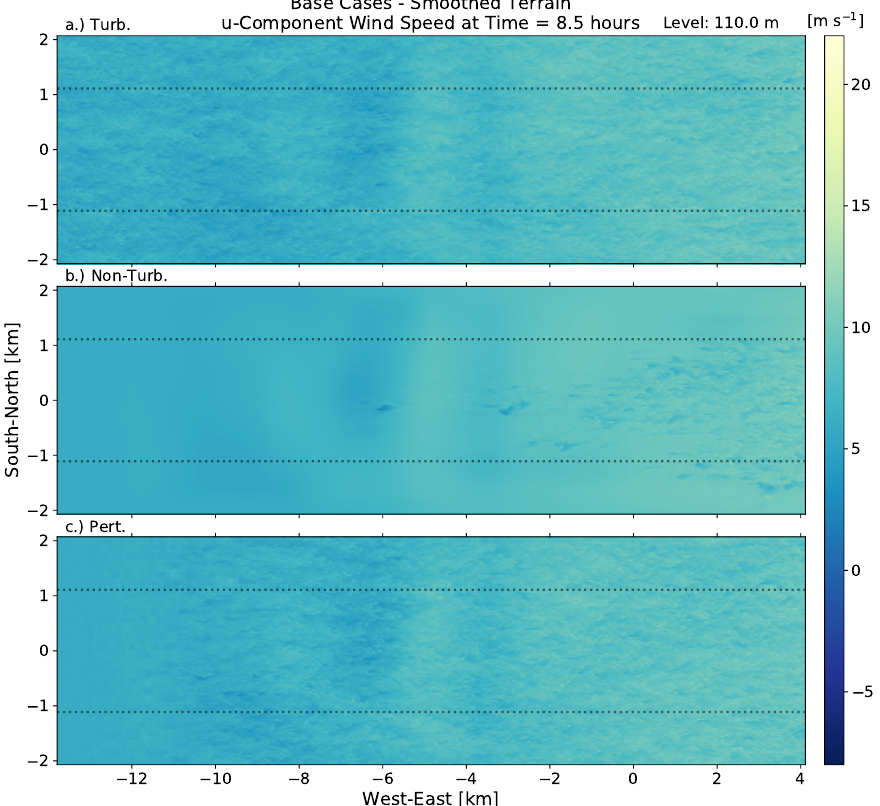
Figure 10. Same as in Figure 4 but for simulations considering the filtered terrain (SMO_base) for the ( a ) Turbulent, ( b ) non-turbulent, and ( c ) cell perturbation simulations. Inspecting the flow field statistics (Figure 11), the mean of the perturbation case follows closely with the turbulent inflow case. On the other hand, the non-turbulent inflow case has a mean u -component wind speed greater than that of the other cases from Tower Line 3, onward. We suspect that this is due to the lack of turbulent transport between the surface drag and its momentum sink and the flow at 110 m thus preventing a deceleration of the wind field. The average variance of the u -component winds shows that the non-turbulent inflow case at 110 m remains non-turbulent until between Tower Lines 3 and 4. At Tower Line 4, the skewness and kurtosis both spike as the flow oscillates between non-turbulent and turbulent over the time period of interest. This is more clearly seen in Figure 12 where the probability distribution functions (PDFs) of the perturbation of u -component velocity for the turbulent inflow (red) and non-turbulent inflow (yellow) cases are shown. In the non-turbulent case, the PDF appears to be singular at Tower Line 3 (a) but then has a very long negative tail by Tower Line 4 (b). The perturbations were calculated as before by removing the exponentially weighted moving average from the time series for the last three hours of simulation. This tail reduces by Tower Line 5 (c) but the distribution does not recover to what is seen in the turbulent inflow case. From here, the variance of the non-turbulent inflow case (Figure 11) fails to reach that of the other two cases. Meanwhile, the skewness and kurtosis appear to all converge on a similar value around Tower Line 7, although the scale is distorted due to large fluctuations around Tower Line